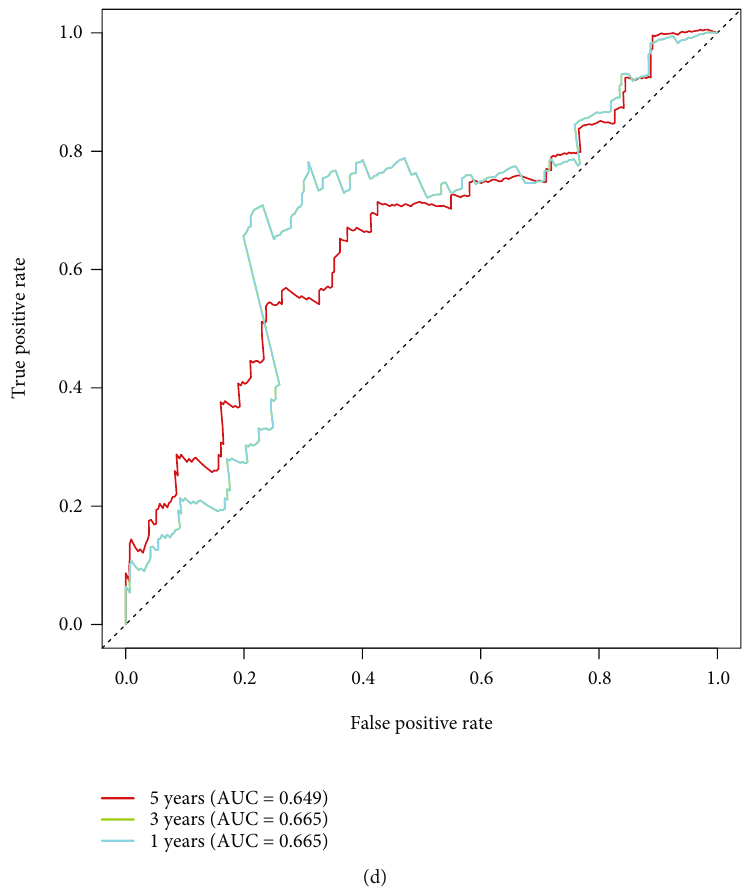
Figure 7: The prognostic value of the eight-ARG signature in GSE44001 dataset. (a) Distribution of risk score and patient survival status of cervical cancer. (b) Expression heat map of high-risk and low-risk groups in GSE44001 dataset. (c) The Kaplan – Meier (KM) curve demonstrates that patients in the high-risk group had a poorer prognosis. (d) Time-dependent ROC curve analysis for survival prediction by the risk